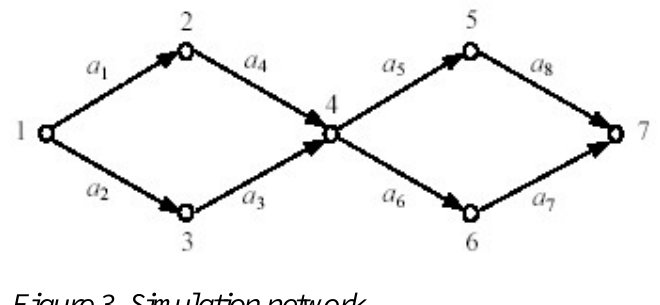
Figure 3. Simulation network